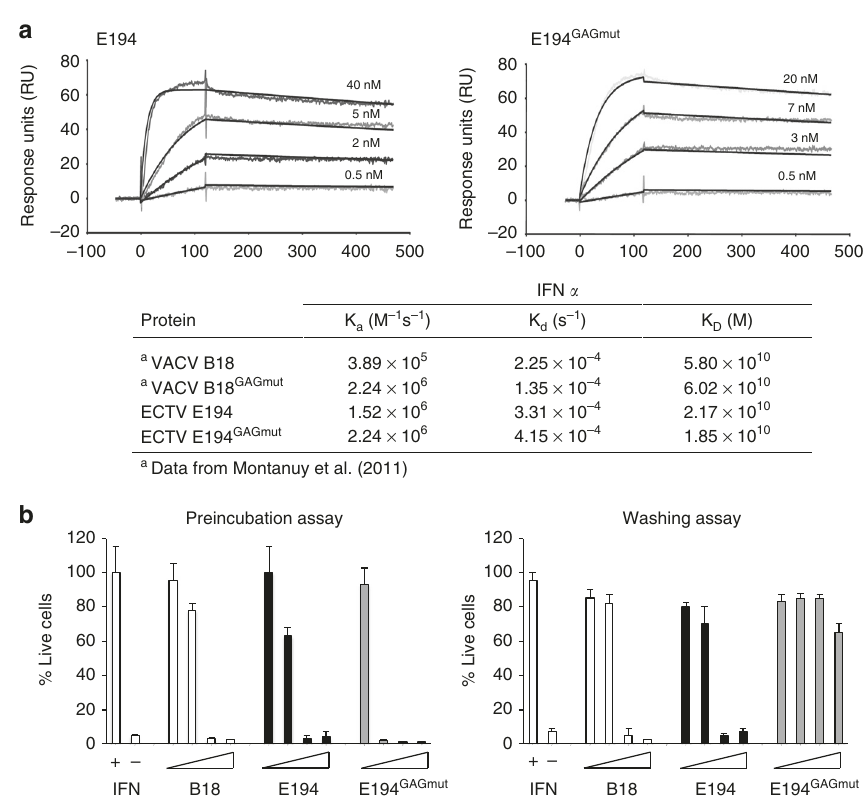
Fig. 2 IFN-I binding properties of the variant E194 protein unable to interact with GAGs. a SPR sensorgrams and fi tting obtained for the determination of the kinetic constants of the interaction of E194 and E194 GAGmut recombinant proteins with mouse IFN α A. E194 or E194 GAGmut were immobilised in a SPR Biacore SA sensor chip and binding and dissociation of several concentrations of mouse IFN α A at 30 μ l/min were recorded and adjusted to a 1:1 Langmuir fi tting (solid lines). The nanomolar concentration corresponding to each sensorgram is indicated. Kinetic parameters and calculated af fi nity constants of E194 and E194 GAGmut are shown in the inset and compared to those previously described for the interaction of human IFN α -2b with VACV B18 and B18 GAGmut (originally named IM15). b To determine the IFN-I blocking activities, in the preincubation assay (left), increasing amounts of recombinant proteins were incubated with 50 U of mouse IFN α A and the mixture added to L929 cells. After 16 h incubation, cells were infected with VSV and cell viability measured at 72 hpi. In the washing assay (right), cells were incubated with recombinant proteins, extensively washed, and then incubated with 50 U of mouse IFN α A as described for the previous assay. In both assays, untreated (IFN -) or IFN-I treated (IFN + ) cells, and also the addition of B18 recombinant protein were incorporated as controls. Data are means showing standard deviations of two independent experiments performed in